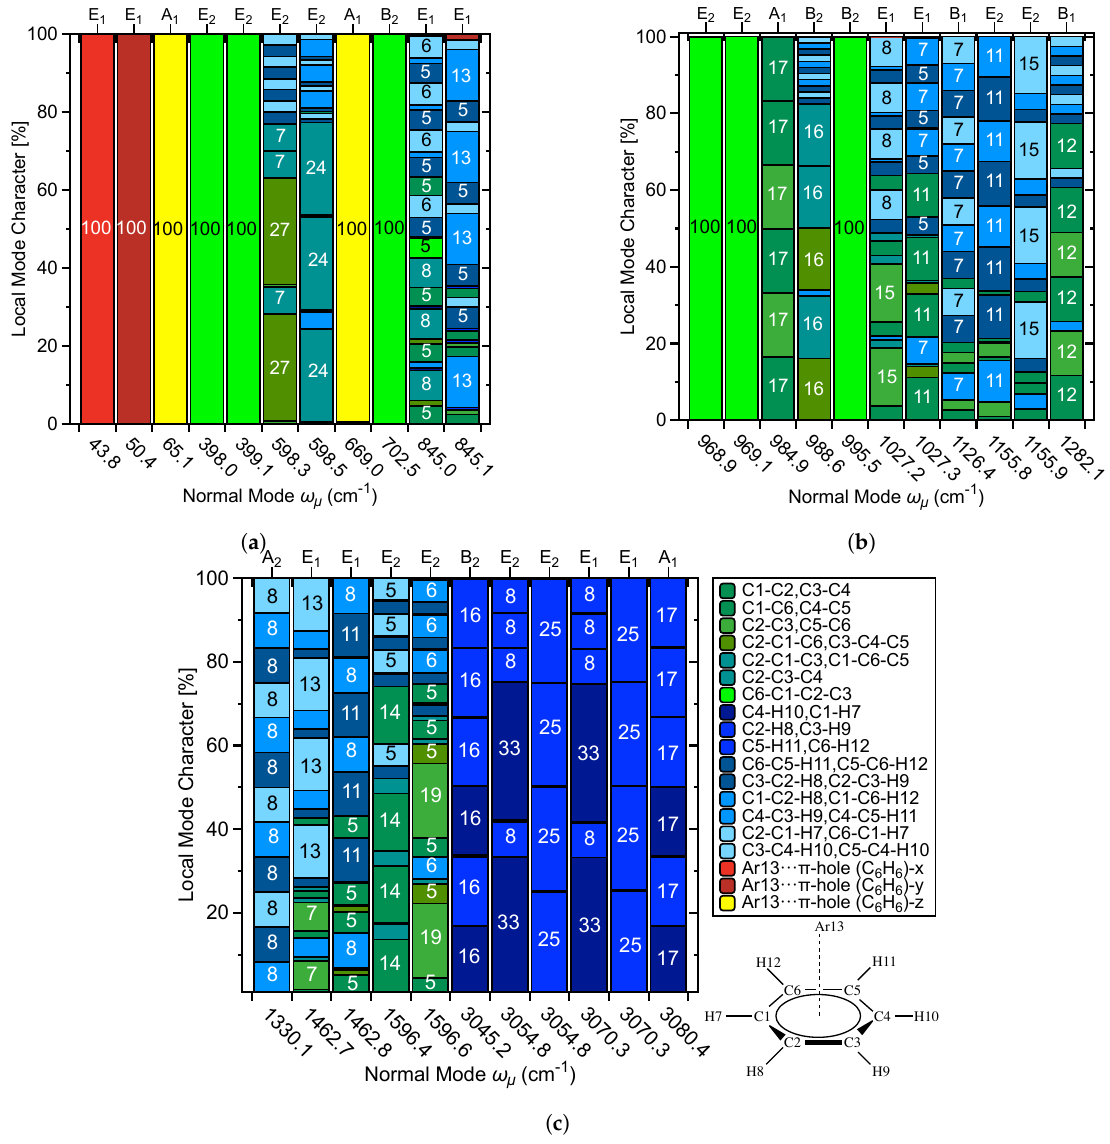
Figure 9. Decomposition of normal vibrational modes into % LVM contributions for the Ar ··· C dimer R2 ; ( a ) % LVM contributions to normal vibrational modes 1–11, ( b ) % LVM contributions to normal vibrational modes 12–22, and ( c ) % LVM contributions to normal vibrational modes